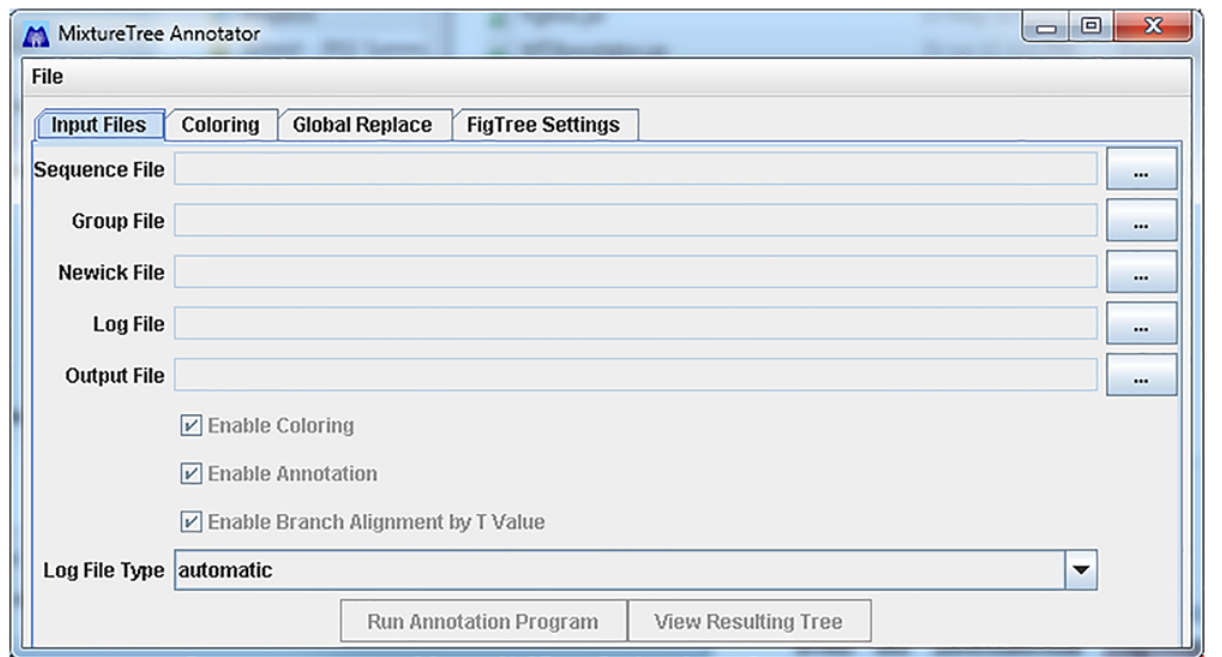
Fig 1. Main Screen of MixtureTree Annotator.